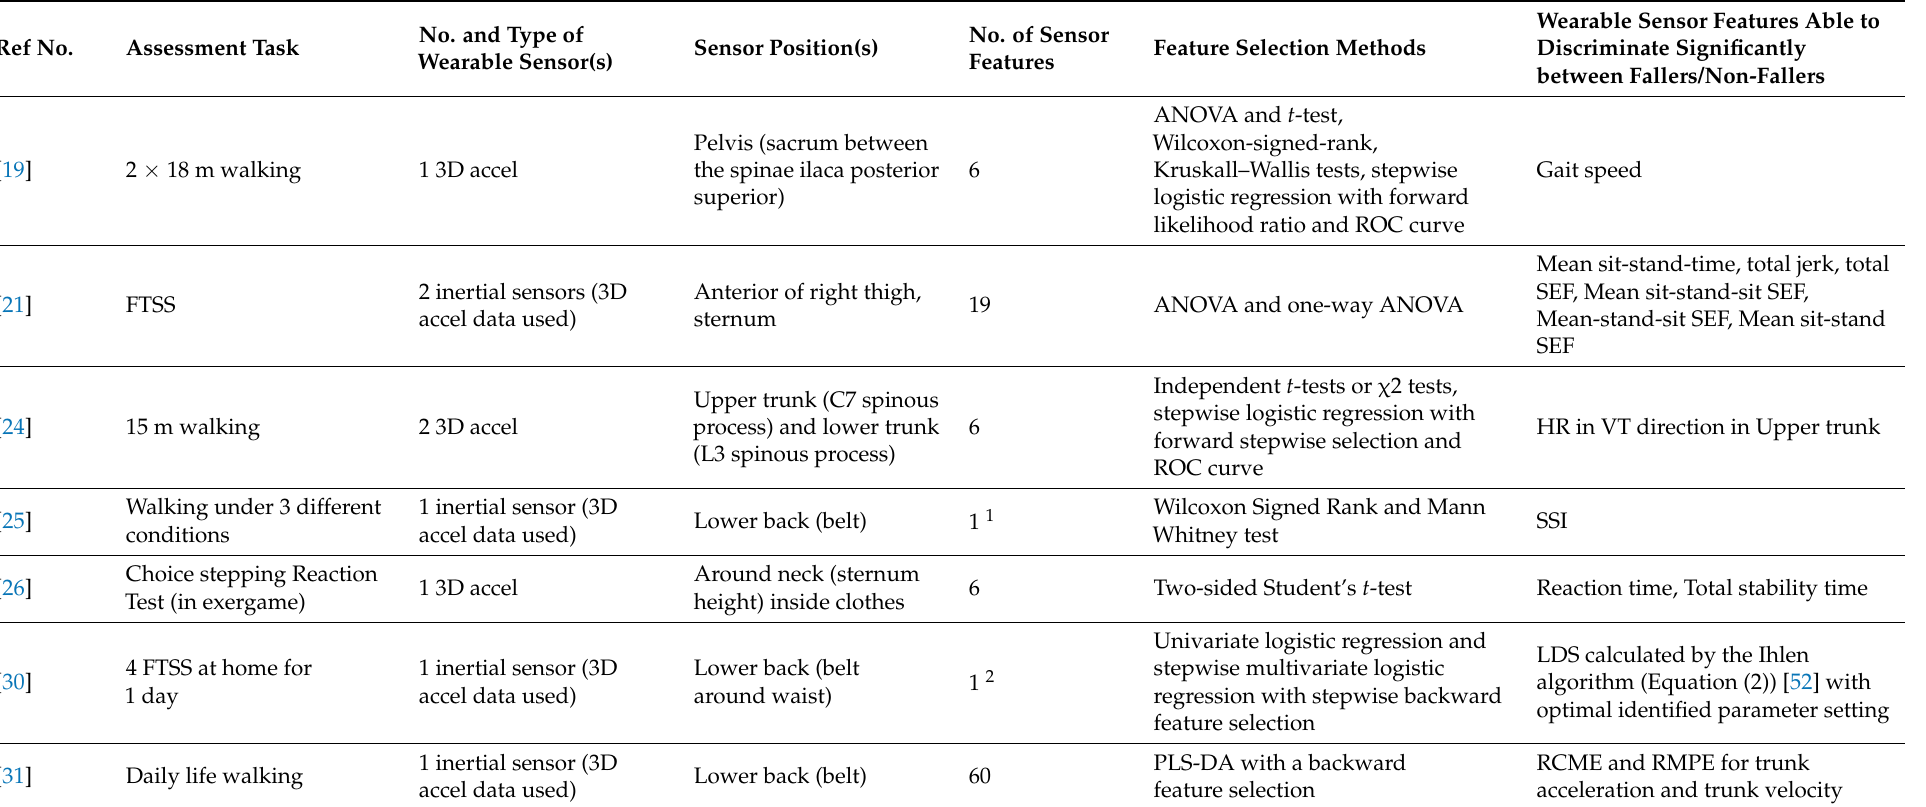
Table 4. Characteristics of SFRA methods which performed discrimination by feature selection. accel = accelerometer, AP = anterior-posterior, DTW = Dynamic Time Warping, EM = Expectation Maximization, GMM = Gaussian Mixture Models, gyro = gyroscope, HR = harmonic ratio, IMF = Intrinsic Mode Function, ML = medio-lateral, MML = Minimum Message Length, PLS-DA = Partial least square discriminatory analysis, RMS = root mean square, ROC = receiver operating characteristic, SEF = Spectral Edge Frequency, VRHMD = VR head-mounted display, VT =